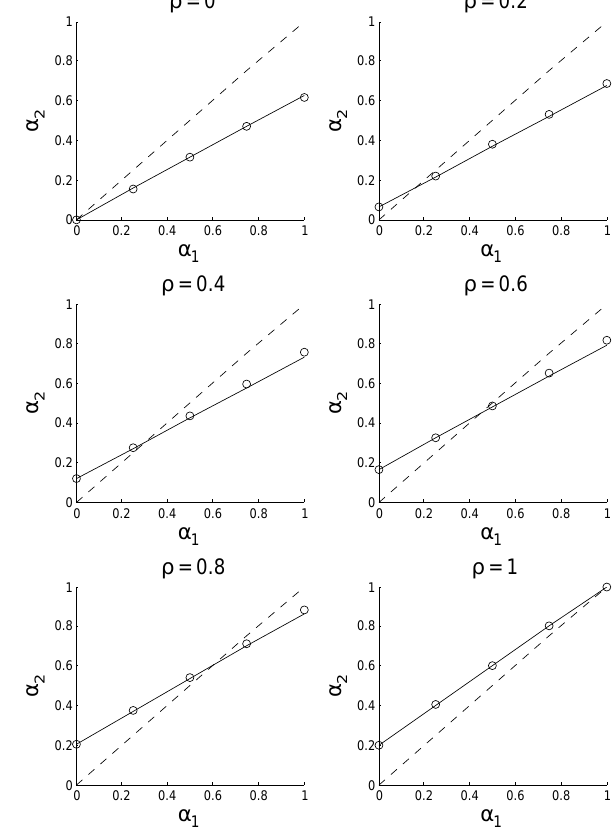
Figure 2. The dependence of α 2 on α 1 for cloud fractions that are uniformly distributed (solid line), where the horizontal correlation coefficient in cloud cover is R = 0, and the vertical correlation co- efficient in cloud cover is ρ . The dashed line is where there would be no scale dependence on α (i.e. α 2 = α 1 ) . The circles are values from